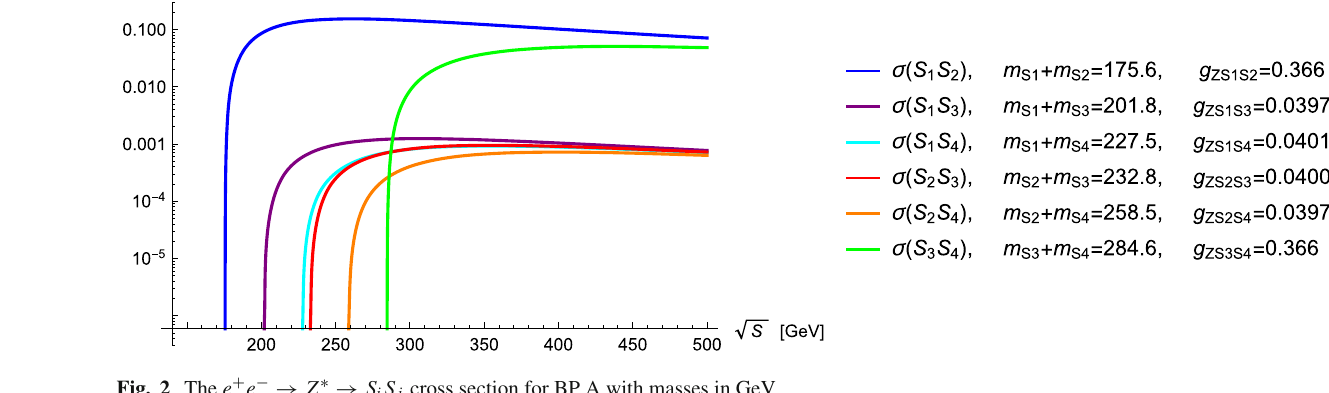
Fig. 2 The e + e − → Z ∗ → S i S j cross section for BP A with masses in GeV